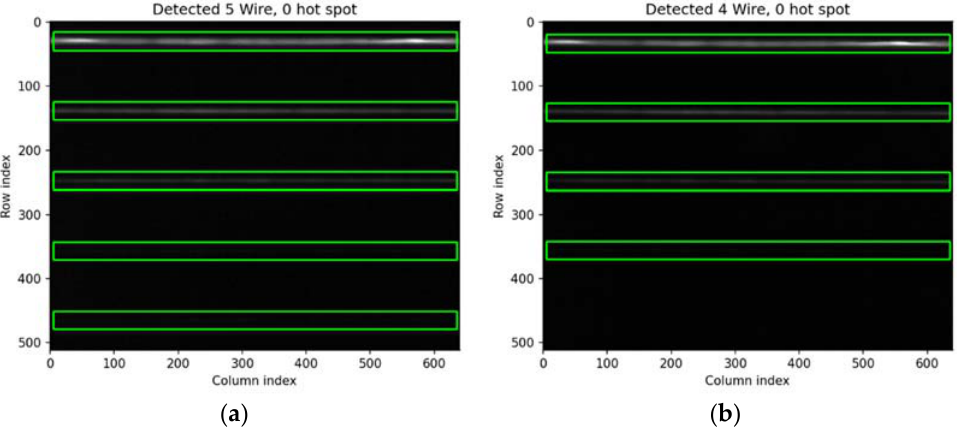
Figure 19. Demonstration of the wire breaks detection using the proposed method of Test Sample 2: ( a ) healthy condition of straight wires; ( b ) one wire break in straight wires.